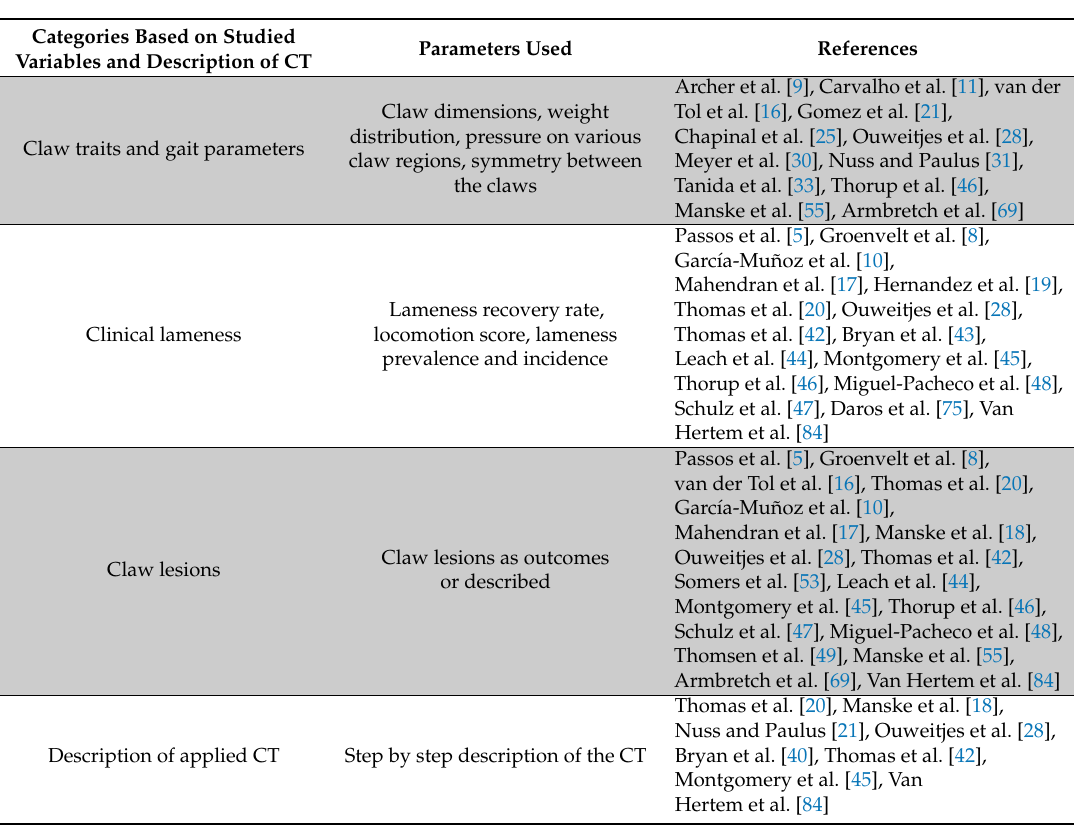
Table 1. Reviewed studies reporting associations between claw trimming and claw health in dairy cows and those with detailed description of applied claw trimming (CT)